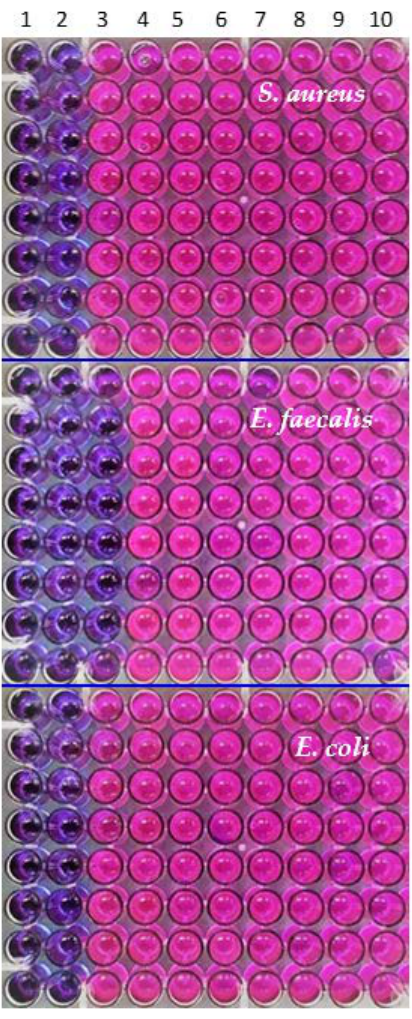
Figure 10. Images of MIC experiments that were conducted with a 96-well round-bottom microtiter plate using a resazurin redox indicator. The concentrations of C-AgNPs were 54, 27, 13.5, 6.76, 3.38, 1.69, 0.84, 0.42, 0.21 and 0.105 µg/mL, respectively, that were labelled as 1–10, where 1 was a higher concentration and 10 was a lower.